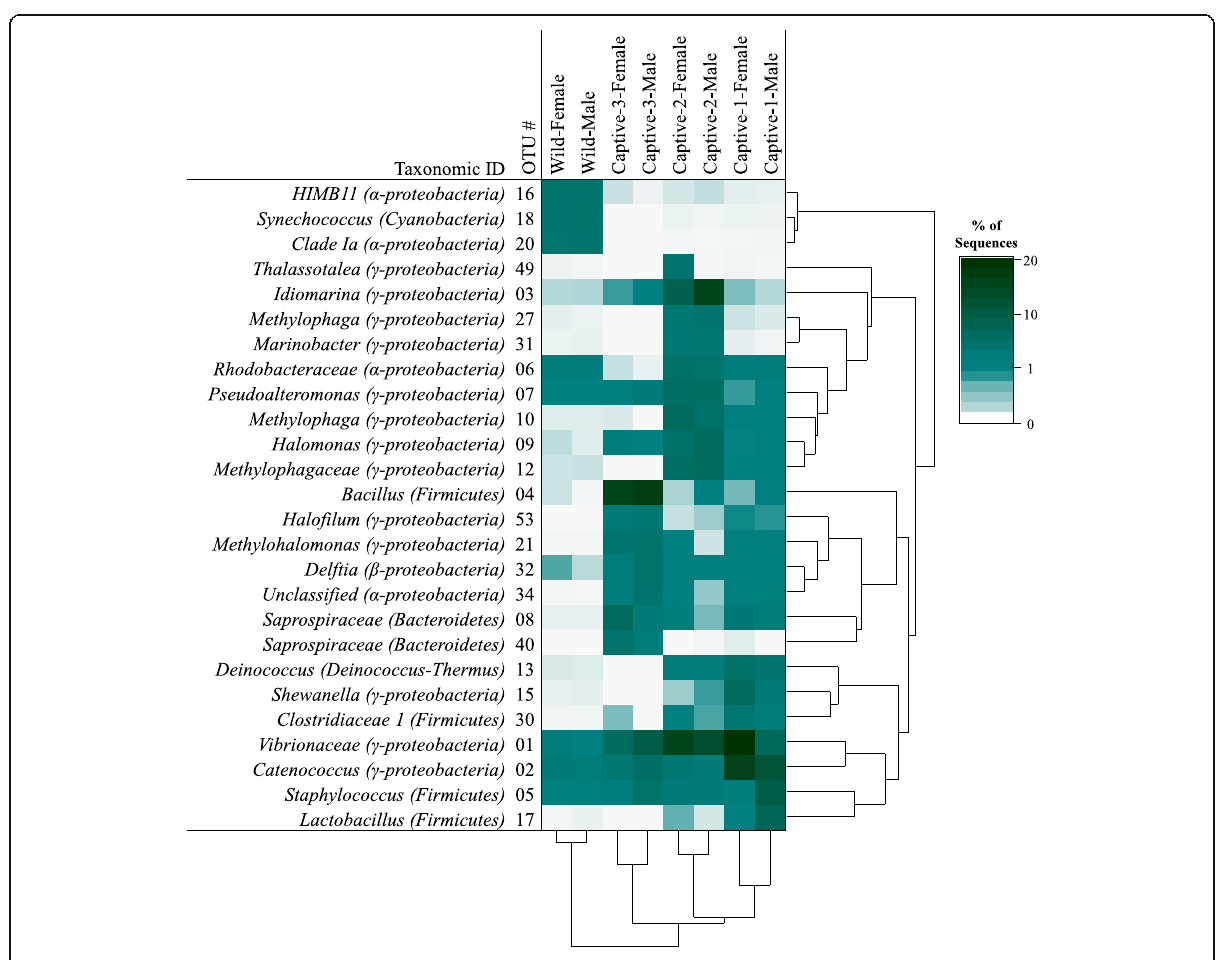
Fig. 3 Heat map indicating relative abundance of discriminatory OTUs among sampling periods